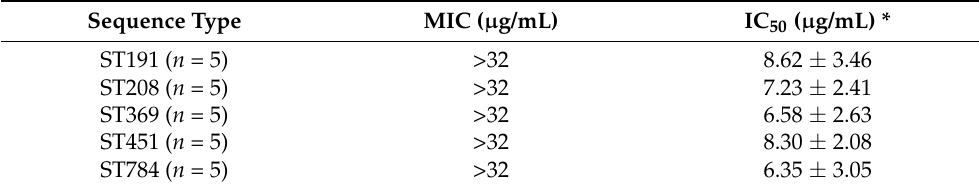
Figure 3. Growth inhibition of Acinetobacter strains by compound 62520. ( A ) Bacteria were cultured in 96-well plates and were then treated with different concentrations of compound 62520. As a control, the same volume of DMSO, used to dissolve the compound, was added (0 μ g/mL). The plates were incubated for 20 h and bacterial growth was measured at OD 600 . The data are representative of two experiments that produced similar results. ( B ) A. baumannii ATCC 17978 treated with different concentrations of compound 62520 for 20 h was inoculated into blood agar plates and then cultured for 20 h. Table 1. Antibacterial activity of compound 62520 against clinical carbapenem-resistant A. baumannii isolates.